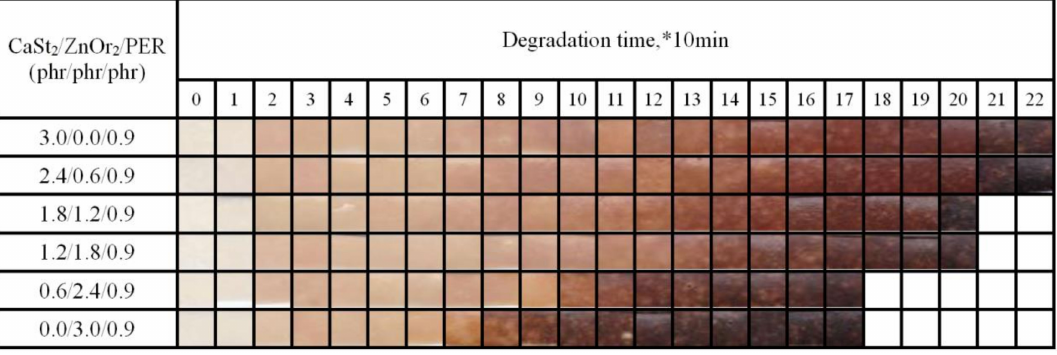
Figure 15. The effects of discoloration for PVC with different proportions of CaSt 2 /ZnOr 2 /PER thermal stabilizers at 180 ◦